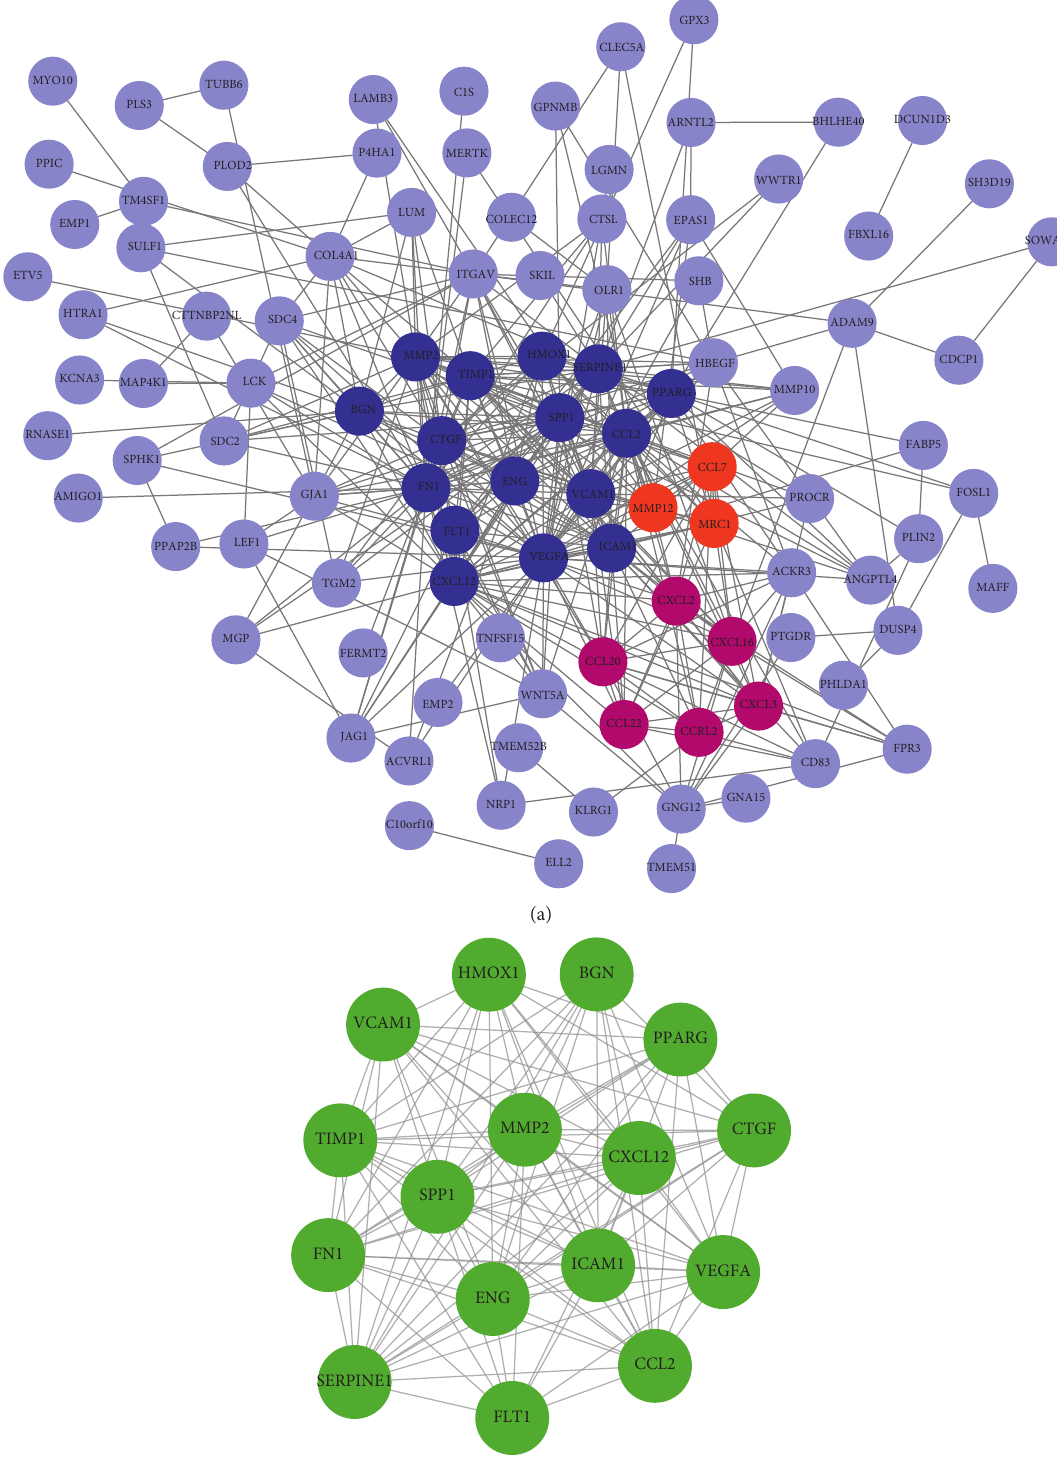
Figure 4: (a) The PPI network analysis for DEGs. Different clusters identified by MCODE were marked with different colors. Sixteen dark blue dots were cluster 1, six purple dots were cluster 2, and three orange dots were cluster 3. (b) The PPI network of 16 hub genes. PPI: protein-protein interaction; MCODE: molecular complex